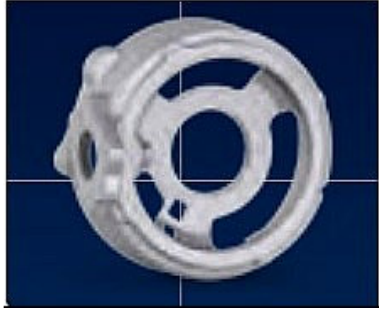
Figure 4. Adaptor flange model.